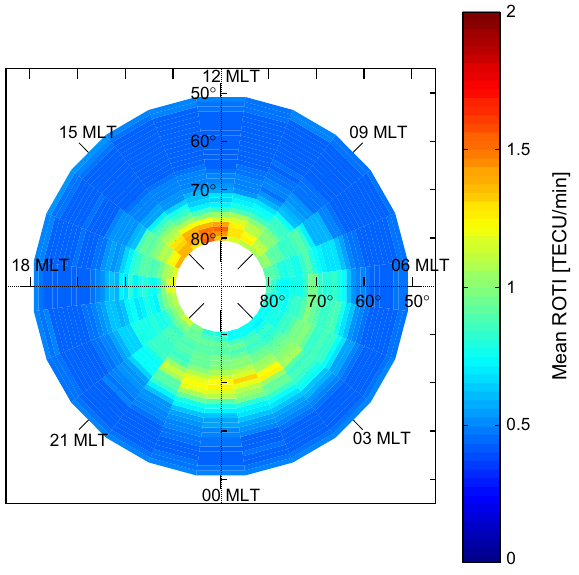
Fig. 8. Mean ROTI for 2012, with an elevation cutoff of 30